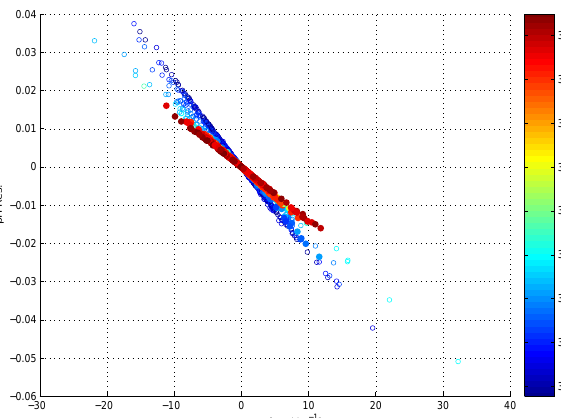
Fig. 4. Relationship between the TA and pH25T residuals for the M84/3 data (filled symbols) and some CARINA cruises (open symbols). The colour code stands for salinity.